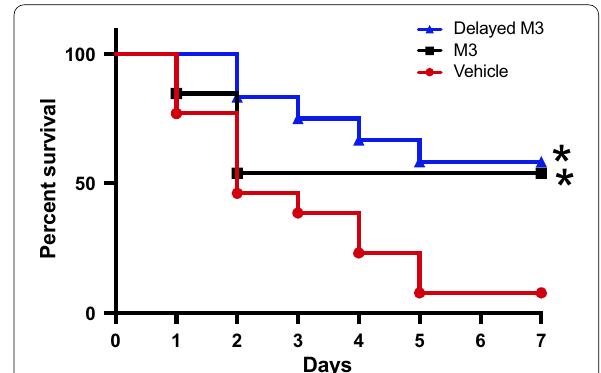
Fig. 5 M3 improves survival in neonatal murine sepsis. Mouse pups were injected with a reduced dose of cecal slurry (0.175 mg/g BW) and treated with either M3 or normal saline vehicle. The square black line represents M3 treatment at the time of cecal slurry injection. The triangle blue line represents M3 treatment 2 h after sepsis injection. N